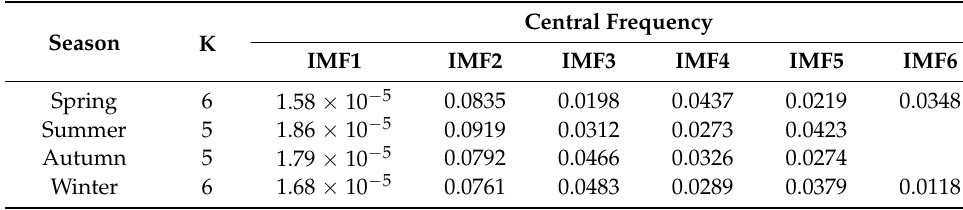
Table 5. Load decomposition component central